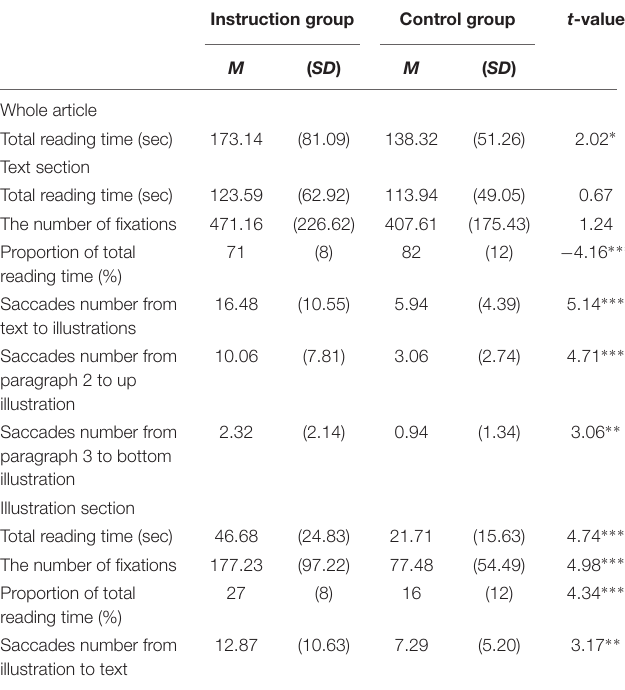
TABLE 5 | Questionnaire ratings (5-point scale) of subjective perception of the science article for instruction ( N = 31) and control ( N = 31)